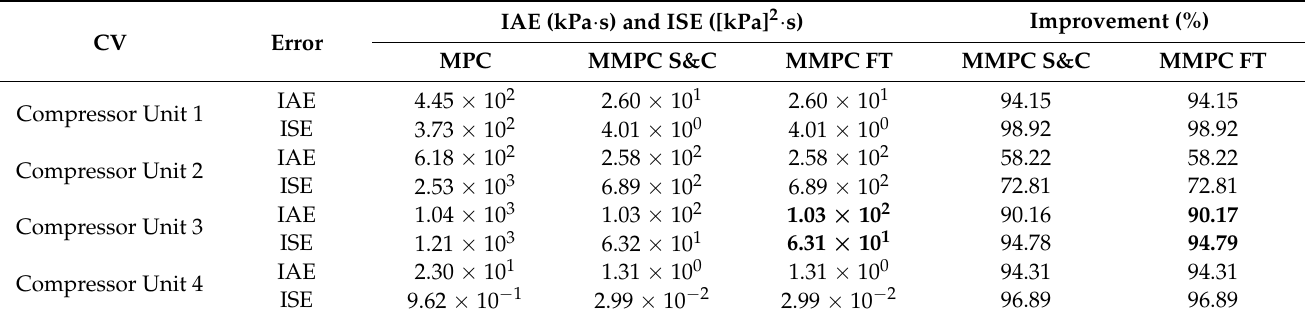
Table 12. Comparison of IAE and ISE on the compressor unit with changes on compressor unit 2 (MIMO Model 2).